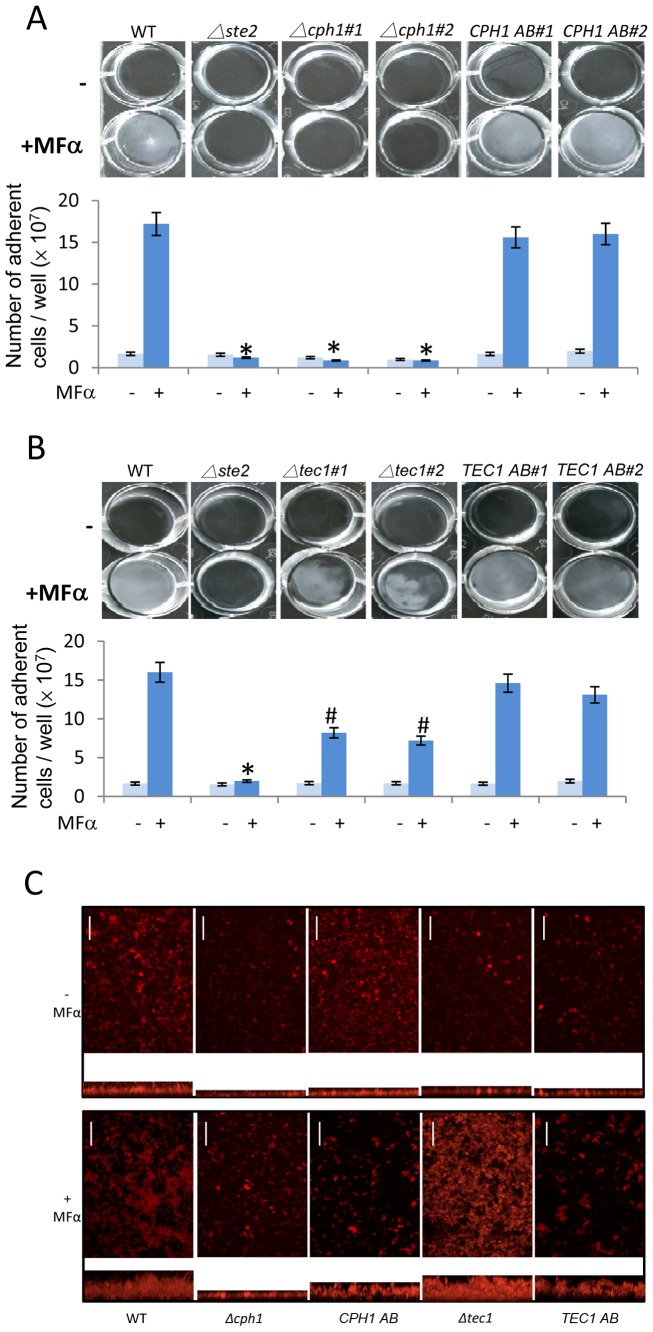
Role of Cph1 and Tec1 in the C. albicans response to pheromone by white cells.Pheromone-stimulated biofilm formation was measured in an adherence to plastic assay. P37005 cells (or mutant derivatives) were inoculated into 6-well cluster plates and treated with 10 µM α pheromone (MFα) for 24 h at room temperature. Wells were washed to remove non-adherent cells and photographed, or cells in the biofilm resuspended and quantified. (A) Cph1 is essential for pheromone-mediated biofilm formation. (B) Pheromone-stimulated biofilm formation is reduced, but not abolished, in the absence of Tec1. (C) Confocal scanning laser microscopy of biofilm formation also indicates that Cph1, but not Tec1, is necessary for biofilm formation in response to pheromone. For each image, the top panel shows the top view and the bottom panel shows the reconstructed side view, with the plastic substrate at the bottom of the image. Scale bars are 50 µm. AB indicates strains in which the target gene has been reintegrated into the mutant background. Values are the mean ± SD from two independent experiments with at least three replicates. “#” represents P<0.05 and “*” represents P<0.001 for WT v. mutant. Light blue bars on graphs, no pheromone added. Dark blue bars on graphs, pheromone present. (WT P37005: CAY716; Δste2/Δste2: CAY1234; Δcph1/Δcph1: CAY2899; CPH1 AB: CAY3028; Δtec1/Δtec1: CAY2506; TEC1 AB: CAY2750).